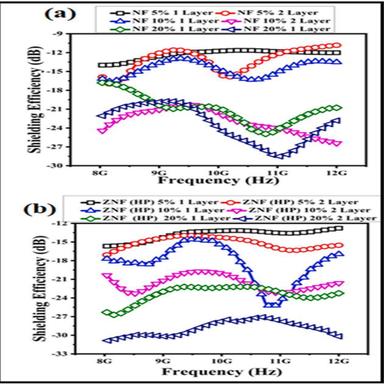
Shielding efficiency of (a) NF and (b) ZNF(HP) in X band.